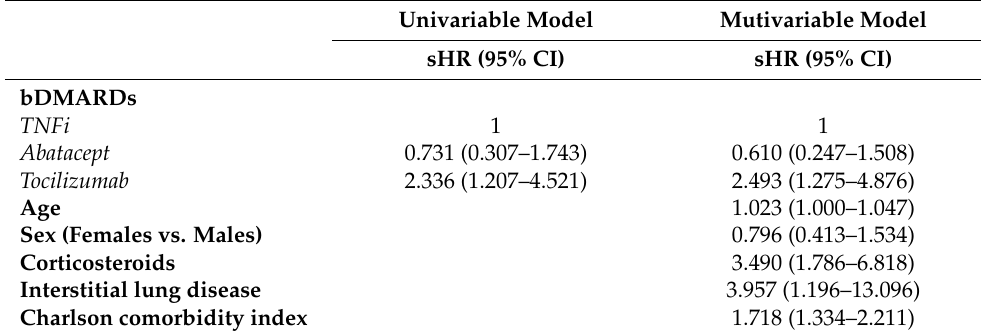
Table 2. Sub-distribution hazard ratios and corresponding 95% confidence intervals for the association between biological disease-modifying anti-rheumatic drugs (bDMARD) and risk of severe